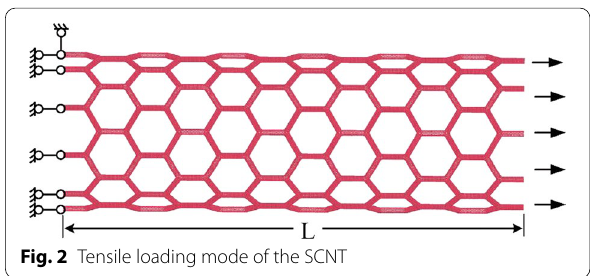
Fig. 2 Tensile loading mode of the